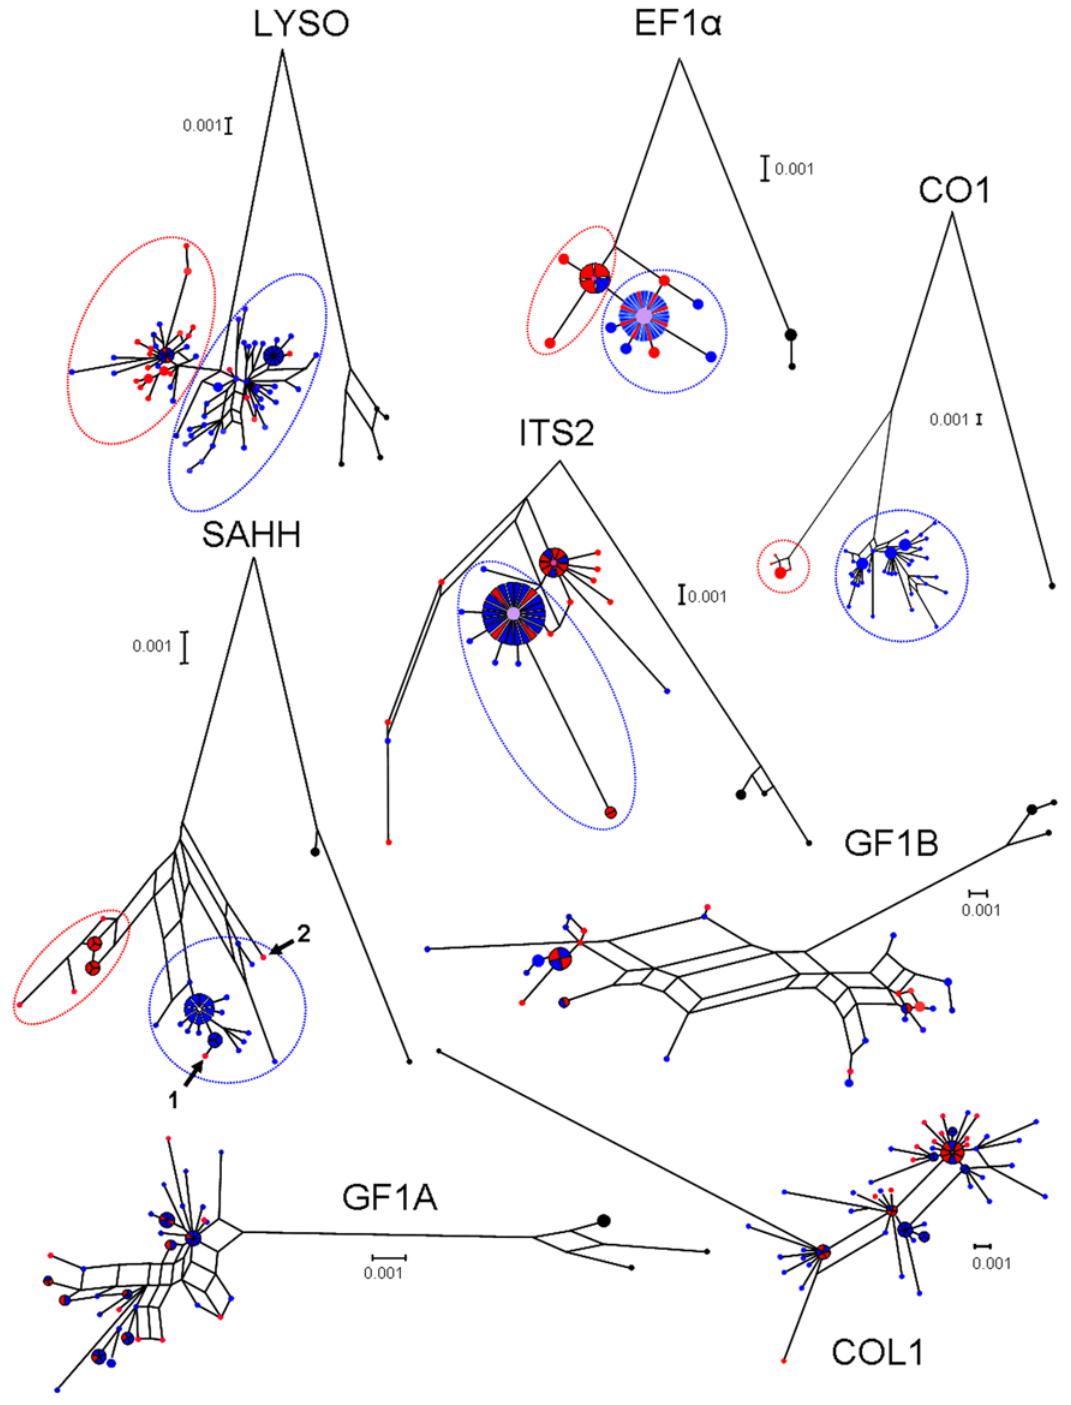
Figure 3. Networks inferred with the NeighborNet algorithm for the 8 loci. In red: alleles from B. azoricus ; in blue: alleles from B. puteoserpentis . Small arrows: introgressed alleles (see discussion). doi:10.1371/journal.pone.0006485.g003 the estimate t (the number of substitutions) to a number of years since population splitting. To convert estimates of the population mutation rate param- eters ( h 1 , h 2 , and h A ) to estimates of effective population size (N 1 , N 2 , and N A , respectively), we estimated the generation time of Bathymodiolus from previous estimations of the mussel individual